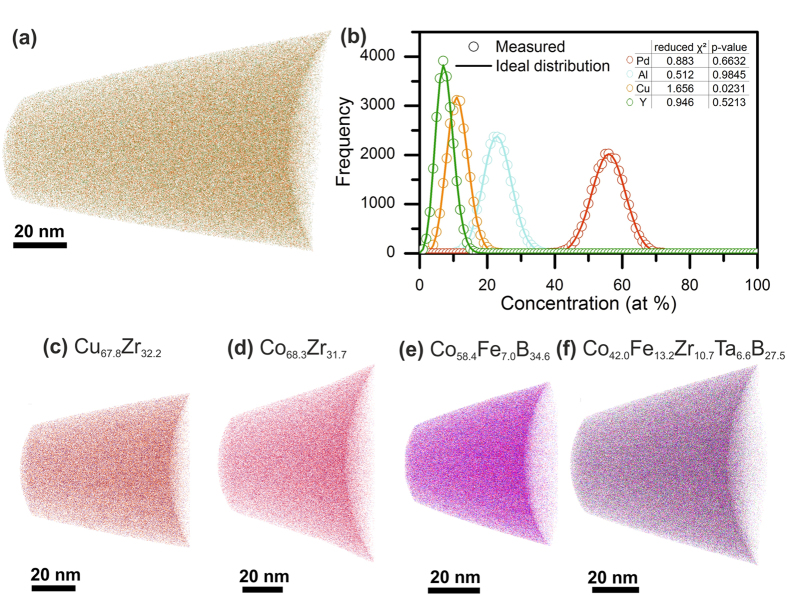
The spatially resolved chemical analysis by atom probe tomography reveals a homogeneous chemical distribution throughout the specimen.(a) The results for the Pd57.0Al23.9Cu11.4Y7.7 thin film metallic glass are shown. (b) The random distributions of all elements for the present concentration are displayed as lines; the measured values, which are in very good agreement with the random distributions, are represented by the open symbols. The inset table shows the deviation between the random and measured distributions; the p-value indicates its randomness22. (c–f) Tomography analysis of the Cu67.8Zr32.2, Co68.3Zr31.7, Co58.4Fe7.0B34.6 and Co42.0Fe13.2Zr10.7Ta6.6B27.5 thin film metallic glasses, respectively.